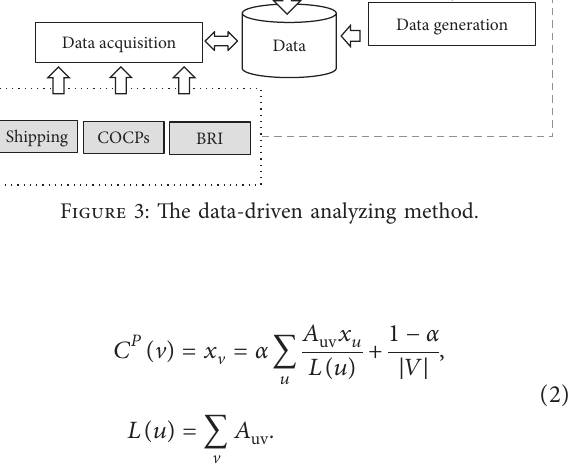
table: year, quantity in millions, sector, subsector, country, and region. A list of 65 IEs in BR is used to classify the data records by the country column into two sets: in BR and out of BR.